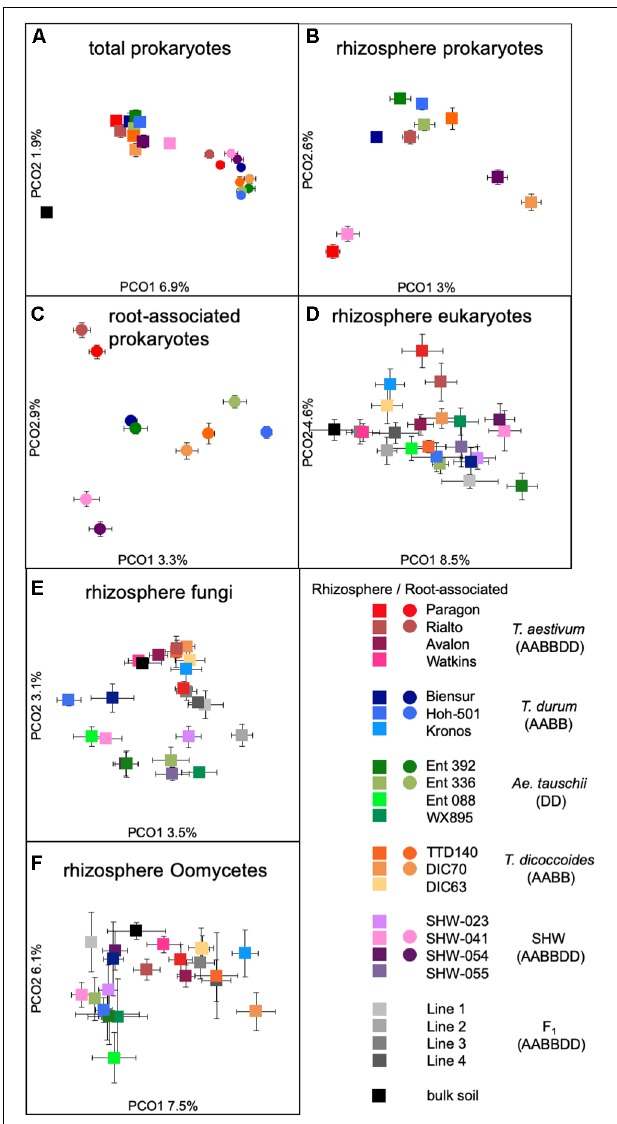
FIGURE 3 | PCoA plots of (A) total prokaryotic community, (B) prokaryotic rhizosphere community, (C) root-associated community, (D) eukaryotic rhizosphere community, (E) fungal rhizosphere community, and (F) Oomycetes rhizosphere community. Data points represent averaged (mean) location of all individual samples belonging to a given group, while error bars represent standard error.